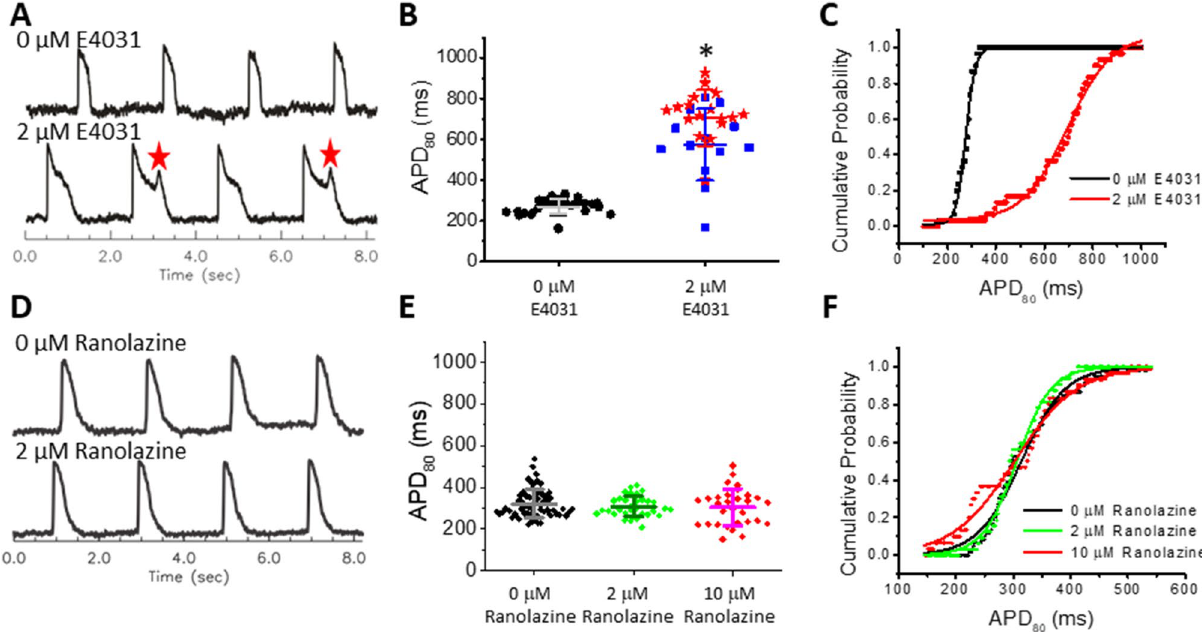
Figure 4. Differentiation between compounds with high risk (E4301) and low risk (ranolazine) for arrhythmia in hiPSC-CM LP with 5% hCF microtissues. ( A ) Representative V m traces from a microtissue (exposed to DMSO vehicle) before and after exposure to E4031 (0 µM and 2 µM, respectively). EADs are marked with red stars. ( B , C ) Scatter plot ( B ) and cumulative probability ( C ) of APD 80 (n = 33 microtissues per group). Values shown by lines in (B) are means ± SD, and APs with EADs are displayed with red stars. 0 μM control was significantly different from each group (vs. no EAD-blue and vs. EAD-red, * p < 0.05). ( D ) Representative V m traces from a microtissue before and after exposure to a therapeutic dose (2 μM) of ranolazine. ( E , F ) Scatter plot ( E ) and cumulative probability plot ( F ) for APD 80 (n = 31). Values shown by lines in (E) are means ± SD. APD was not significantly different between any doses of